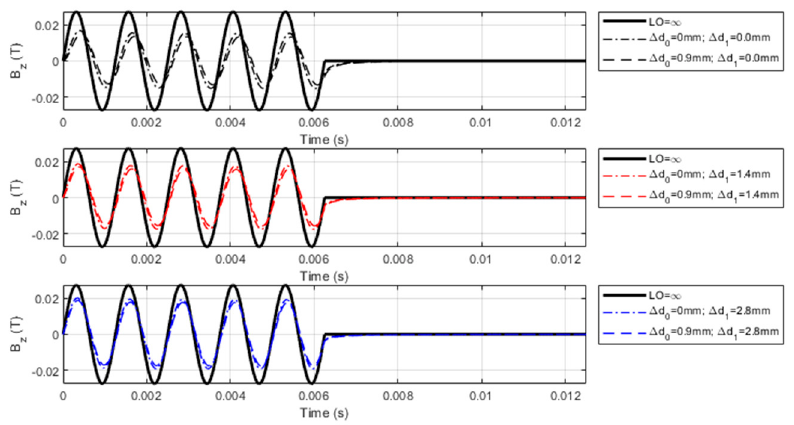
∆ d ff erent ∆ d 0 against di